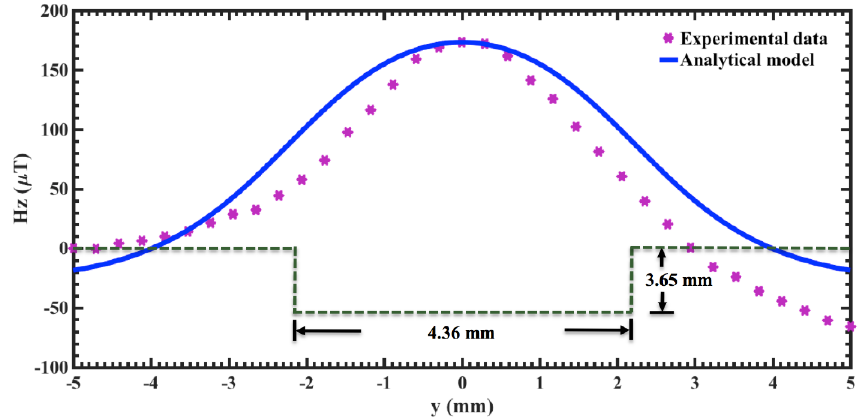
Figure 5. Tangential MMM signal of the rectangular defect S1 of the ASTM A-36 steel pipe.